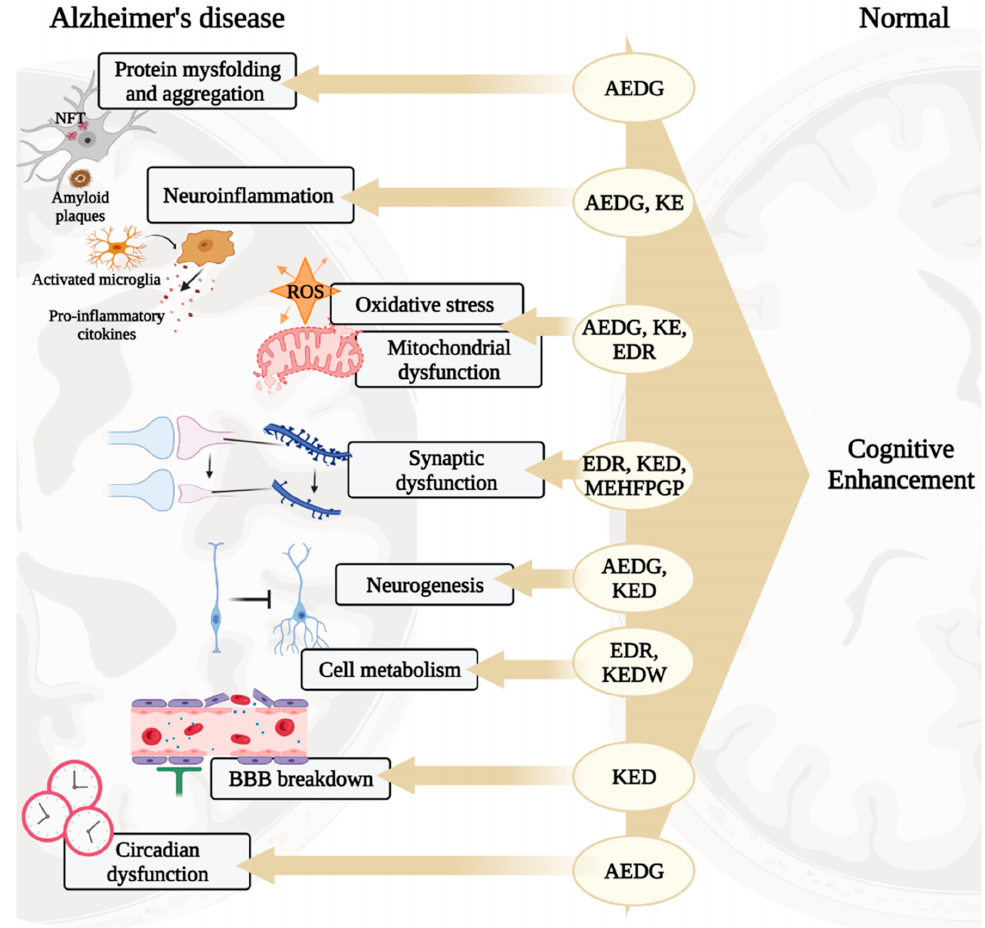
Figure 1. Potential neuroprotective roles of ultrashort peptides (KE, EDR, KED, AEDG, KEDW, and MEHFPGP) in AD. Note: BBB—blood–brain barrier, ROS—reactive oxygen species. (figure created with BioRender.com, accessed on 25 February